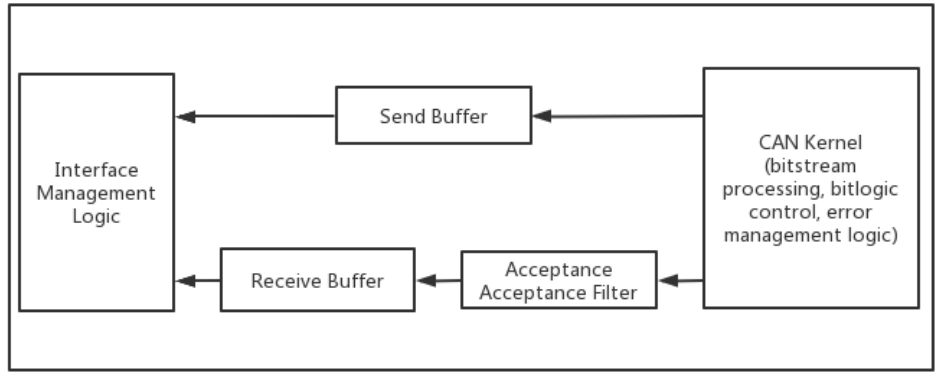
Figure 11. Internal structure of CAN controller.